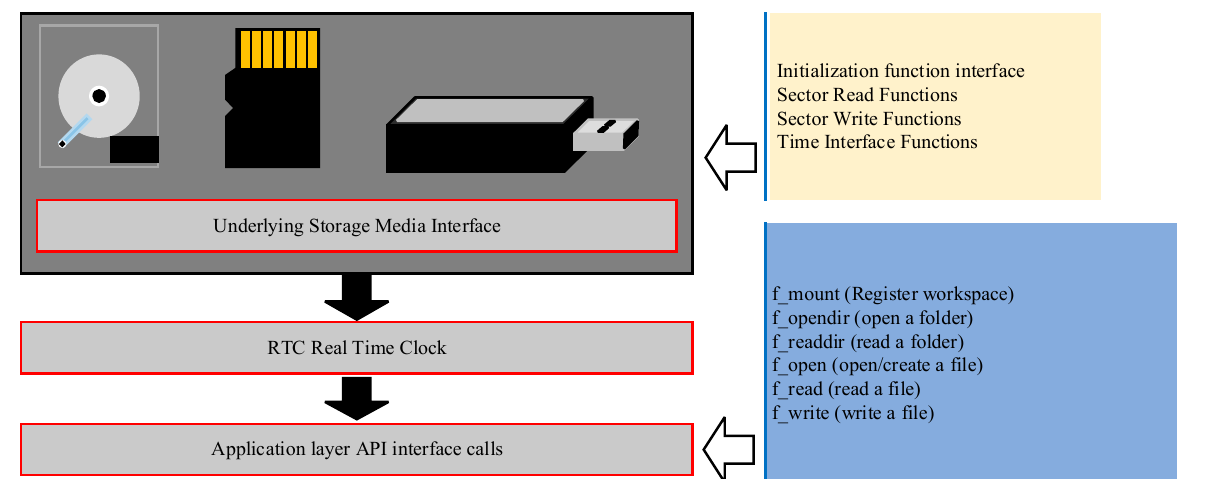
Figure 16. FatFs migration process.